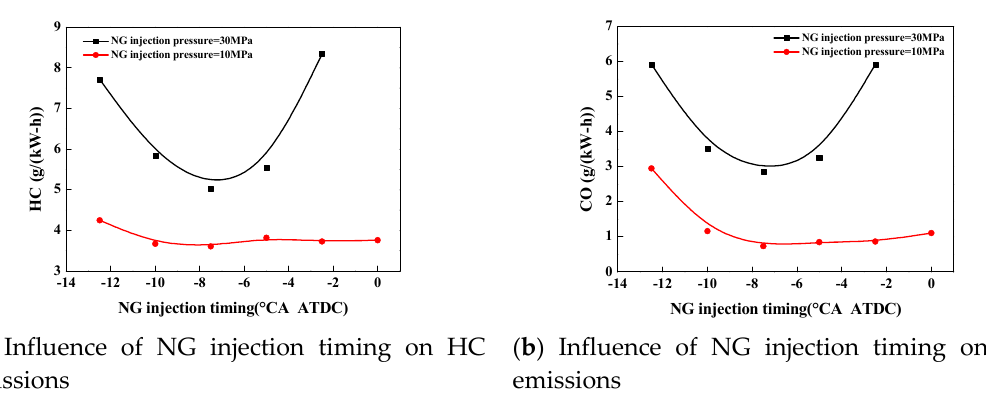
Figure 13. Influences of NG injection timing on HC and CO emissions.